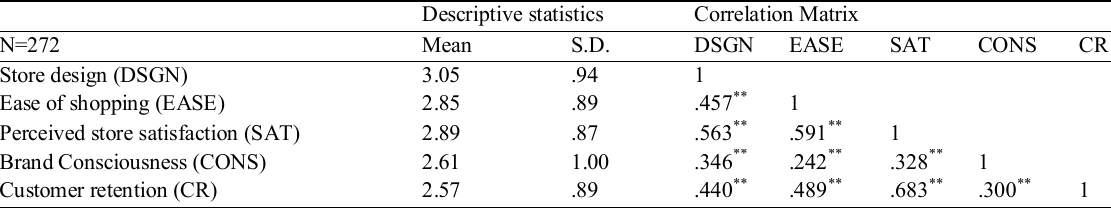
Table 2. Study Data Descriptive Statistics and Correlation Matrix (Brand M) Descriptive